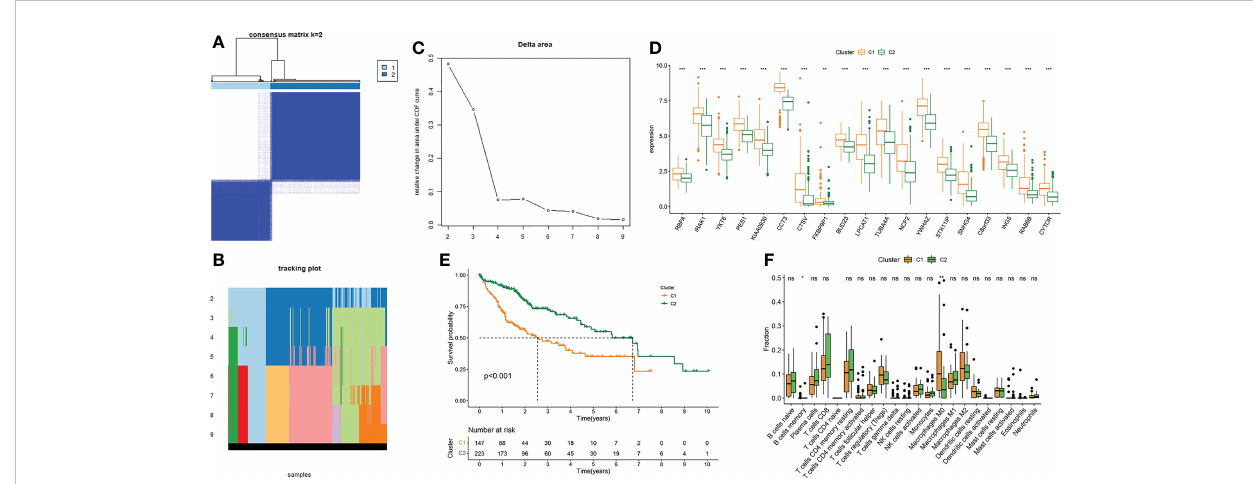
FIGURE 4 Consensus clustering of LIHC based on MRGs. (A – C) Consensus clustering. (D) Differential expressions of the 19 MRGs between subtype 1 and subtype 2. (E) Survival difference between subtype 1 and subtype 2. (F) Differences in 22 immune cells ’ in fi ltration levels between subtype 1 and subtype 2.